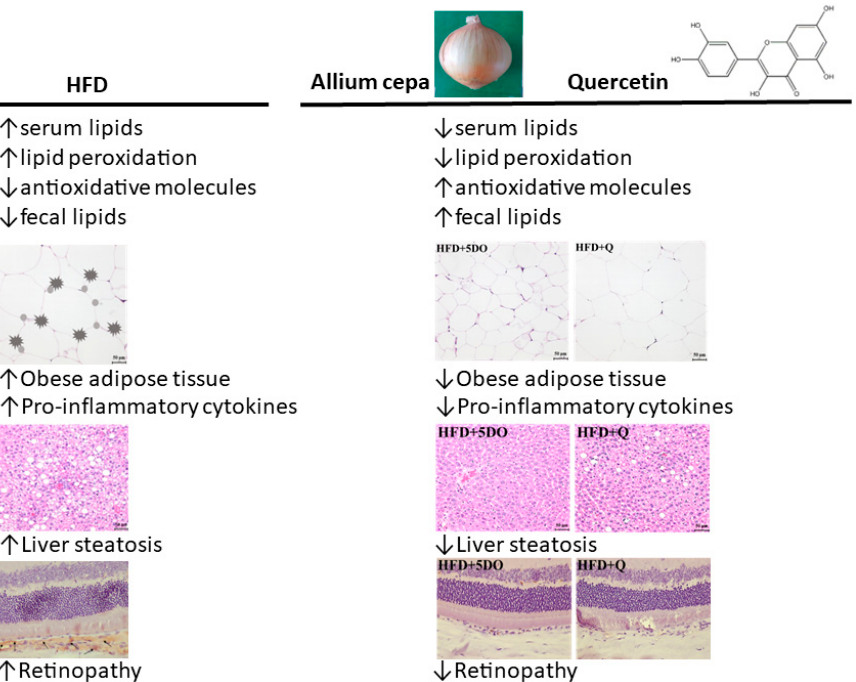
Figure 5. Summary of dried onion powder and quercetin on body lipid, liver steatosis, and retinopathy induced by HFD.